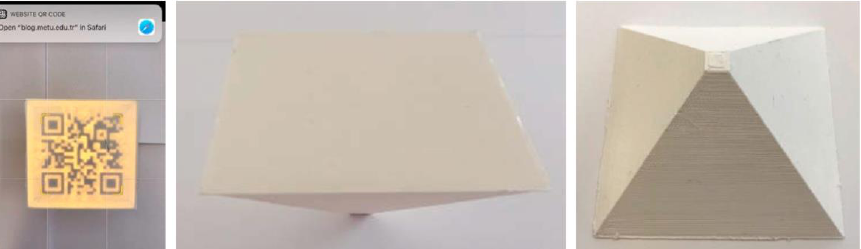
Figure 5. Example of scanning a QR code embedded into a 3D object. Reproduced from Reference [24], Gültekin et al., Procedia Manuf. 2019 , 39 , 519 – 525, https://doi:10.1016/j.promfg.2020.01.411, under the terms of the CC BY-NC-ND license.